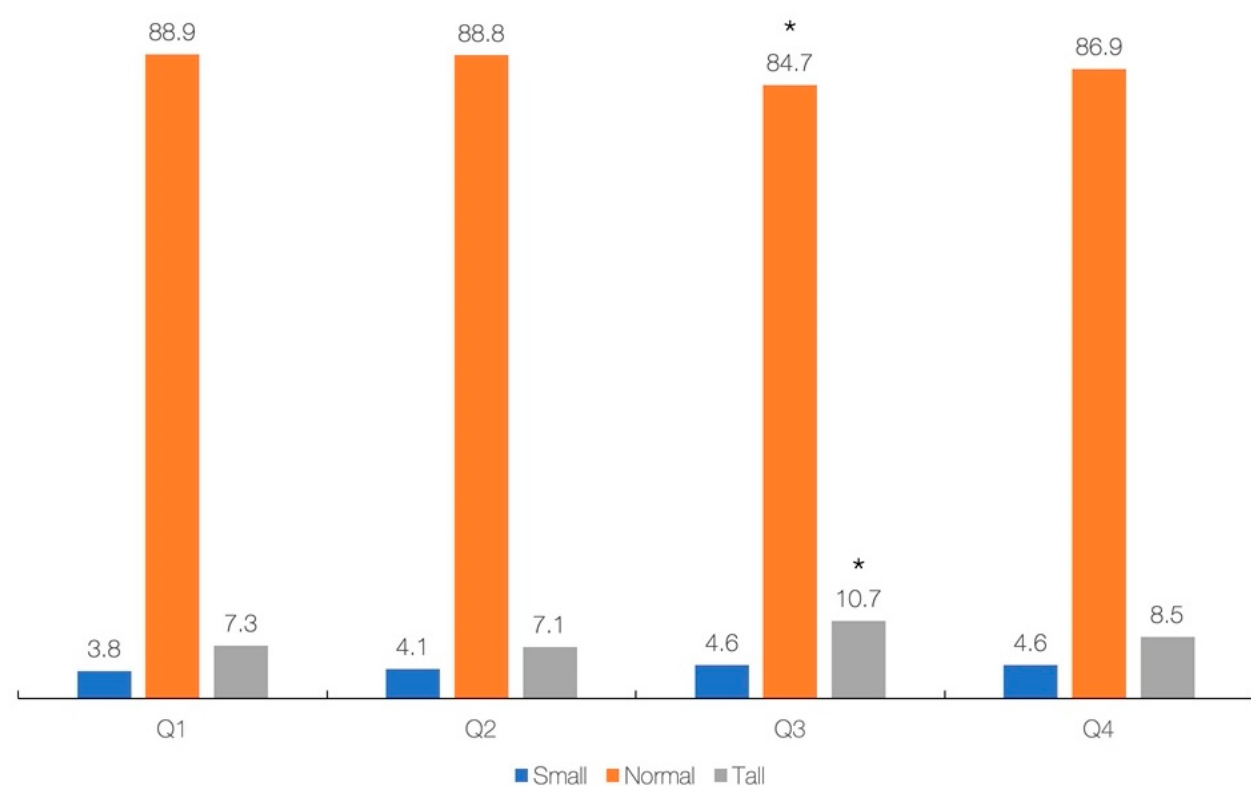
Figure 2. Dietary intake of creatine (g/day) across stature-for-age. Creatine intake across quartiles was 0.00–0.28 g (Q1), 0.28–0.83 g (Q2), 0.84–1.49 g (Q3), and 1.50–8.28 g (Q4). Asterisk (*) indicates a significant difference at p < 0.05 between quartiles.